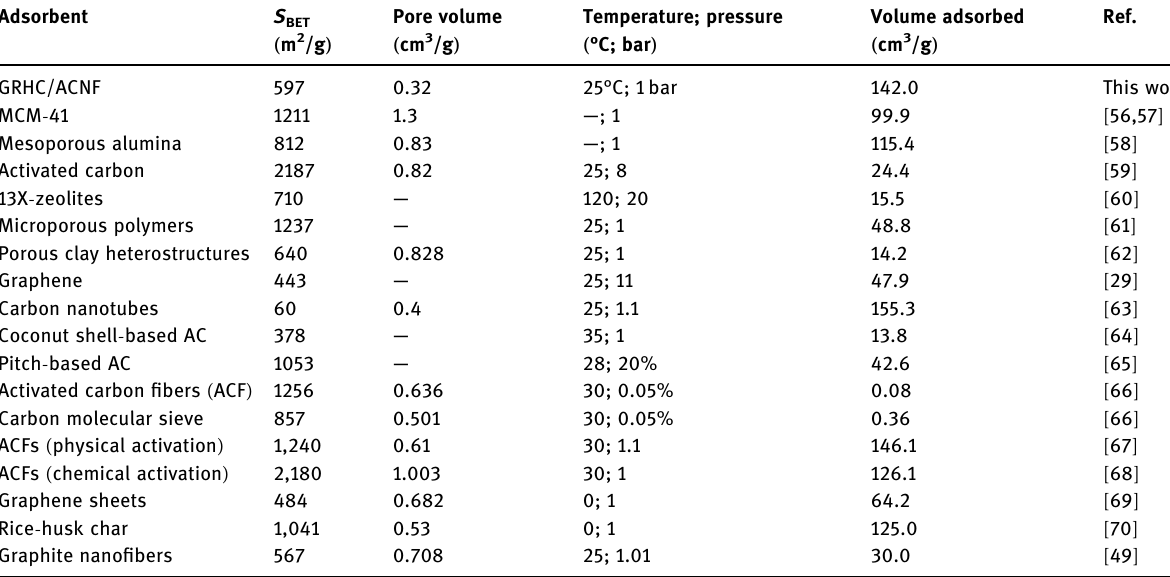
Table 7: Comparison of various types of available sorbent materials Adsorbent